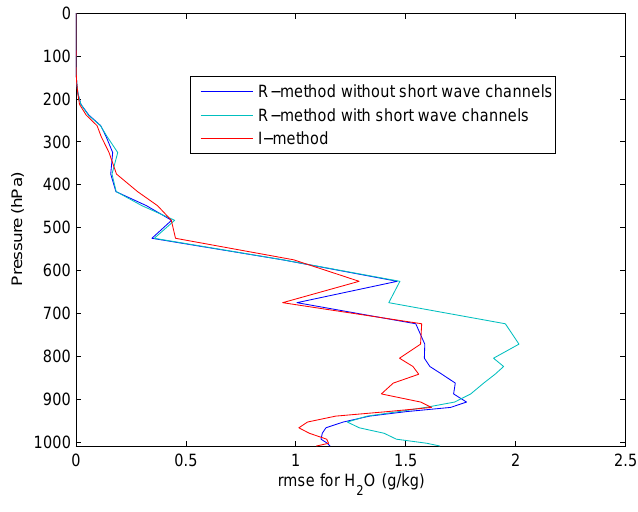
Figure 16. Results for the tropical case study and for daytime IASI soundings. The figure shows the retrieval performance expressed in terms of root mean square error (rmse) for water vapour and compares the I-method to the R-method with and without solar